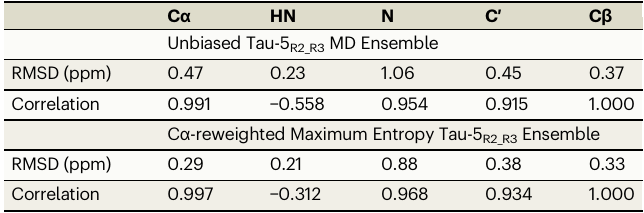
Table 1 | Agreement between calculated and experimental NMR chemical shifts from the 300 K replica of a 74 μ s unbiased REST2 MD simulation of Tau-5 R2_R3 employing the a99SB- disp force fi eld and from a maximum-entropy reweighted ensemble derived using C α NMR chemical shifts as